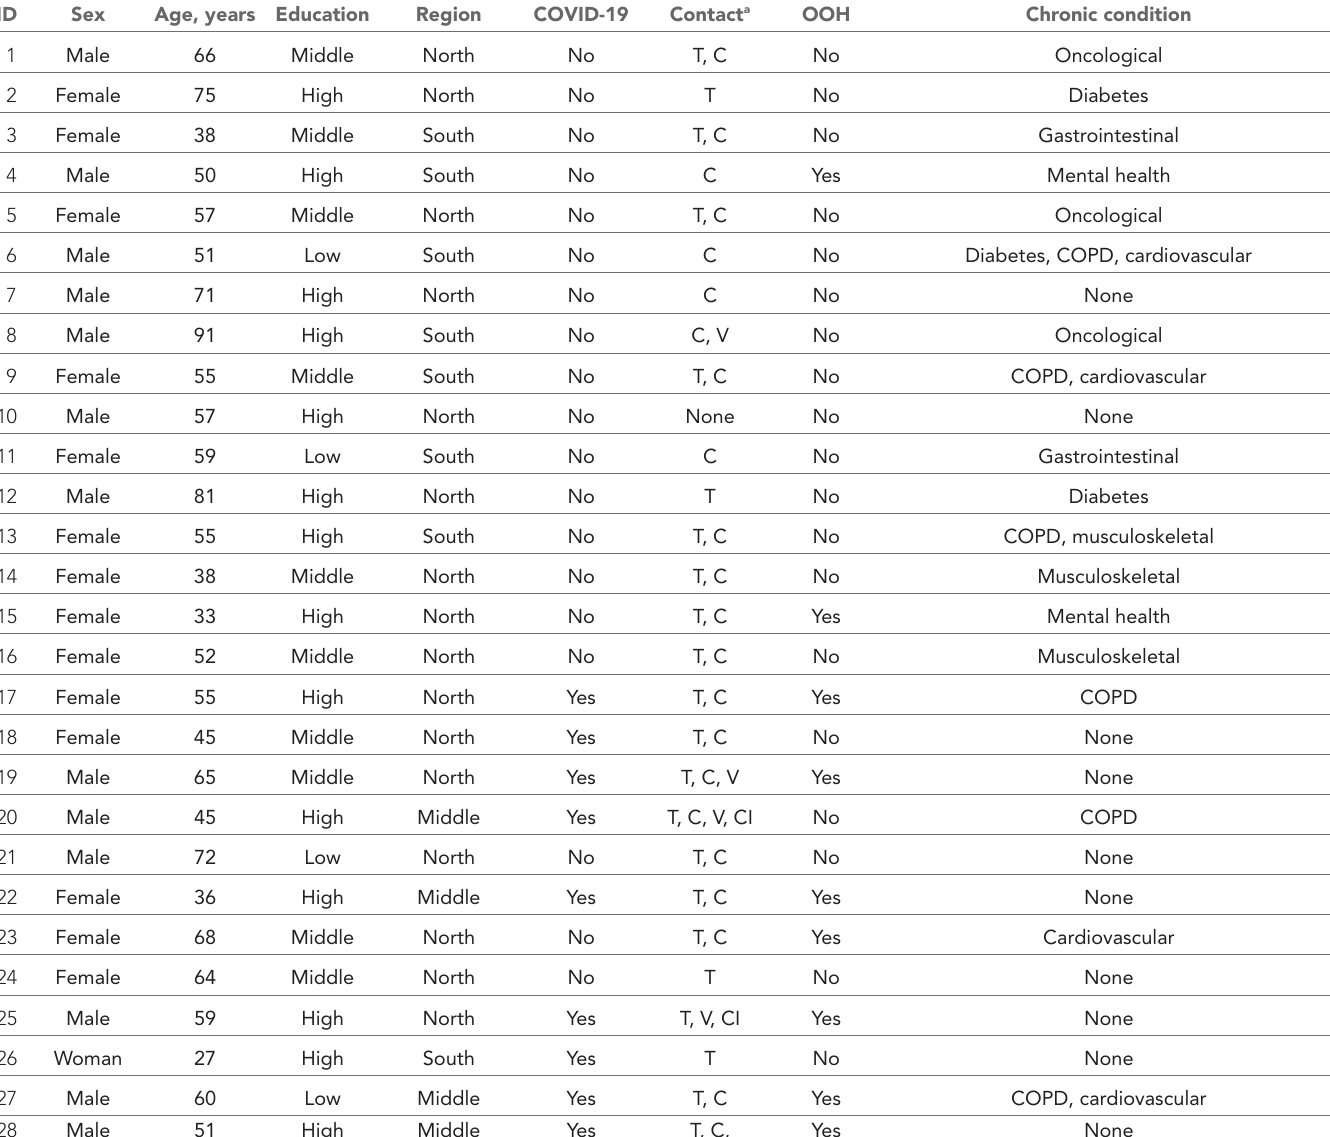
Table 1 Characteristics of the interviewed patients ( n =